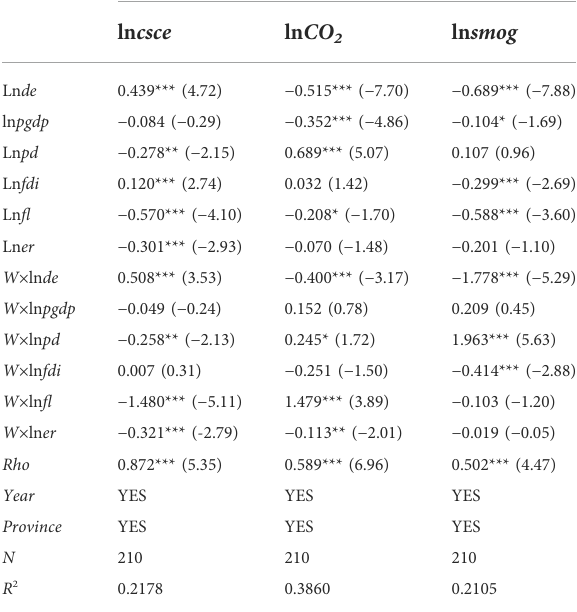
TABLE 8 Coef fi cients of the impact of the digital economy on the synergistic carbon and haze management ef fi ciency, CO 2 emissions and haze mean values with adjacency